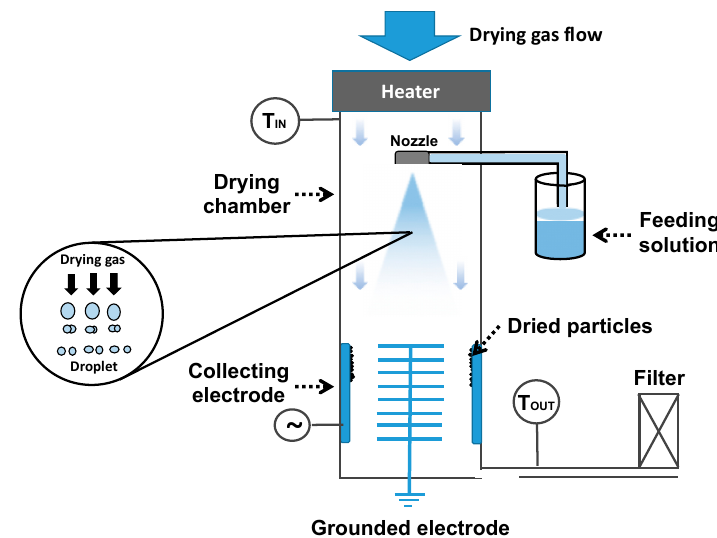
Figure 6. Schematic presentation of the conventional spray-drying technique.